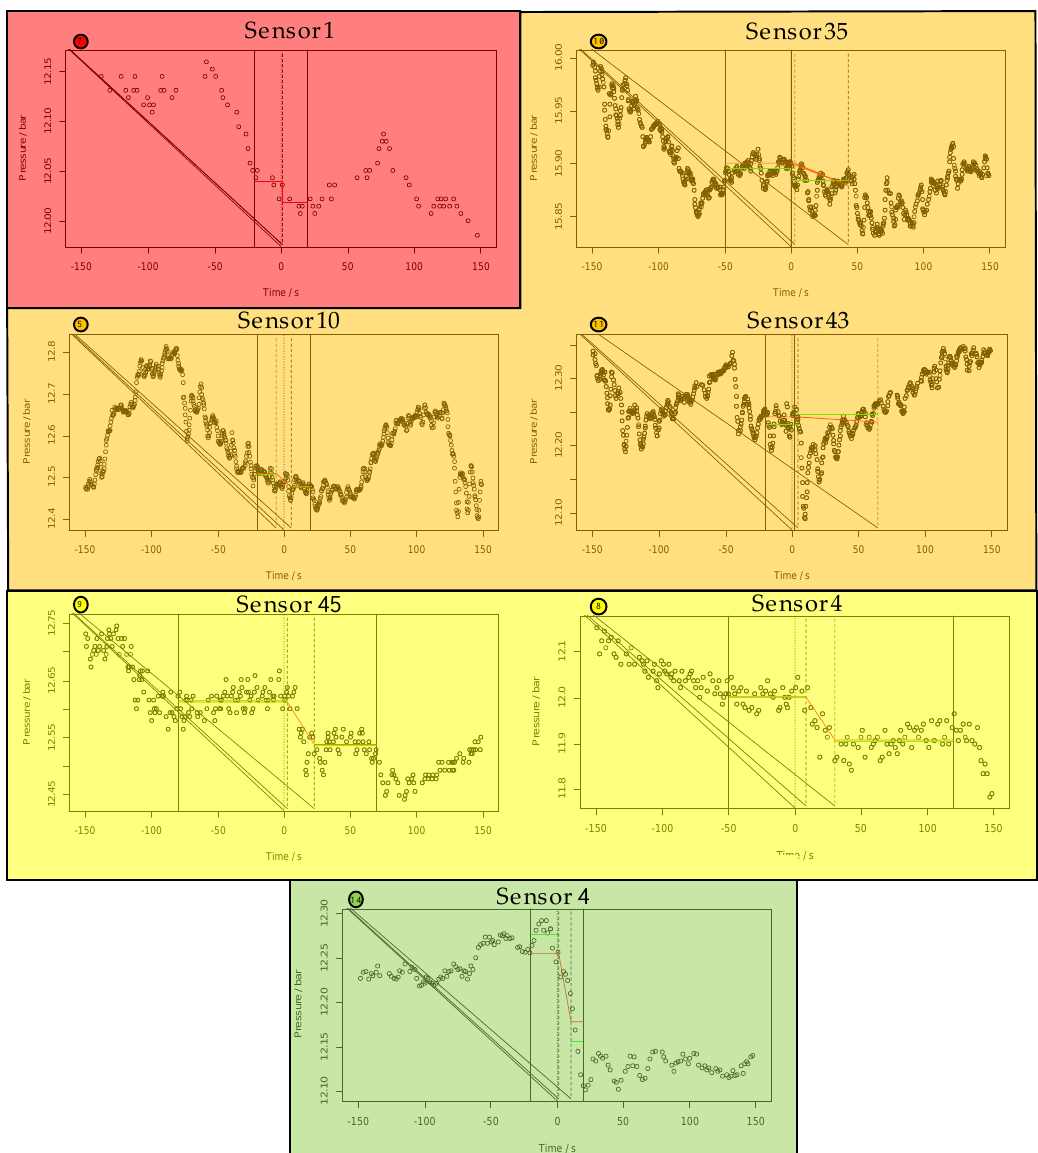
Figure 6. Pressure curves for one exemplary sensor for events where MoFoDatEv extracted small values of ∆ 𝑝 ̅̅̅ .